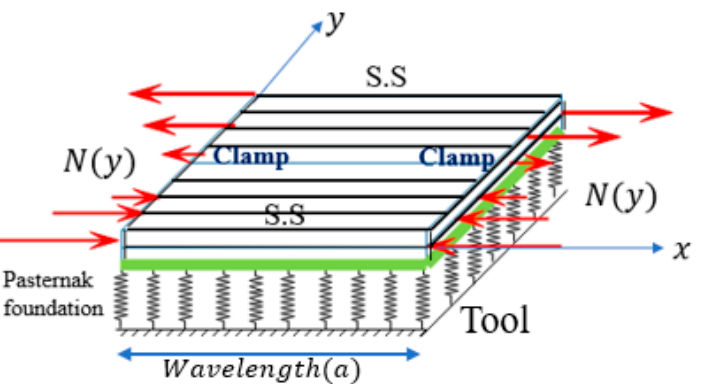
Figure 4. Schematic of a section of tape resting on elastic foundation under combined axial compression and bending.